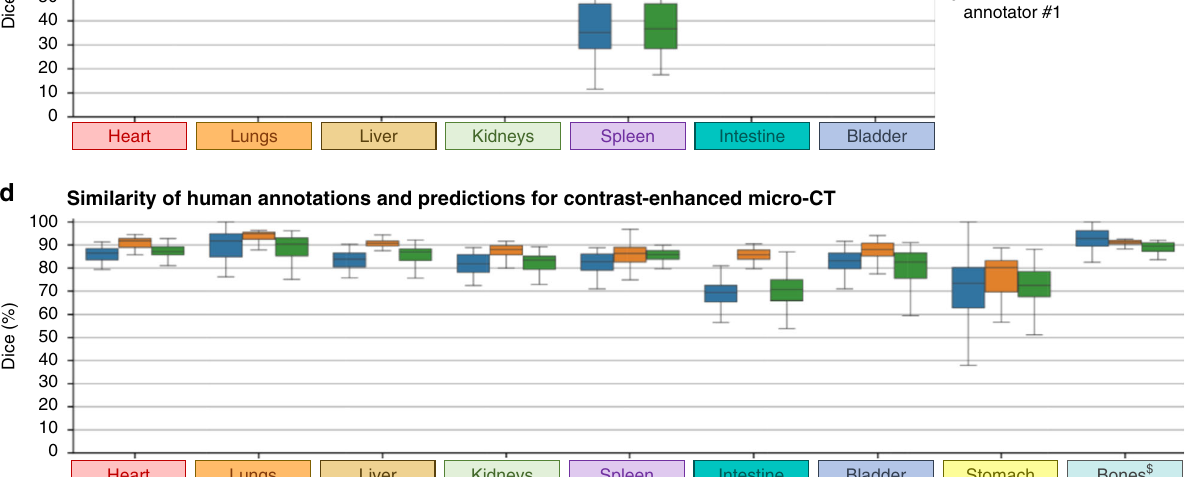
Fig. 4 Human annotation may re fl ect an individual expert ’ s bias. a Raw scan (left) of a spleen in native microCT, the predicted segmentation overlaid with annotation of human expert #1 (middle), and overlaid with annotation of human expert #2 (right). b Same as a but for kidneys in contrast-enhanced micro-CT. c , d Dice score for segmentations by expert #1 vs. expert #2 (blue), AIMOS vs. expert #1 (orange), and AIMOS vs. expert #2 (green). Each box extends from lower to upper quartile values of data, with a black line at the median; the whiskers extend to the outmost data point within 1.5× the interquartile range. c For the native CT dataset, each box plot represents n = 35 independent scans from fi ve biologically independent animals (all that were annotated twice). d For the contrast-enhanced CT dataset, each box plot represents n = 38 independent scans from eight biologically independent animals (all that were annotated twice). Note that AIMOS was trained on annotations from expert #1. $ The human segmentation of bones was done with a semiautomatic thresholding function, which may overestimate human consistency as compared to purely manual segmentation. Source data are provided as a Source Data fi 96%. The same applied for contrast-enhanced microCT, for cation . However, the fact that human interpretation of the same which all scores were between 94 and 97%. These fi ndings indicate that while the predicted segmentations do not exactly data may diverge to the extent described above has far-reaching follow one single, given reference annotation, they do not deviate consequences in a broad range of biological questions. Here, the more from this reference annotation as an independent human capability of AIMOS to predict areas of human disagreement fi nds direct application in quantifying the resulting uncertainty of expert would.